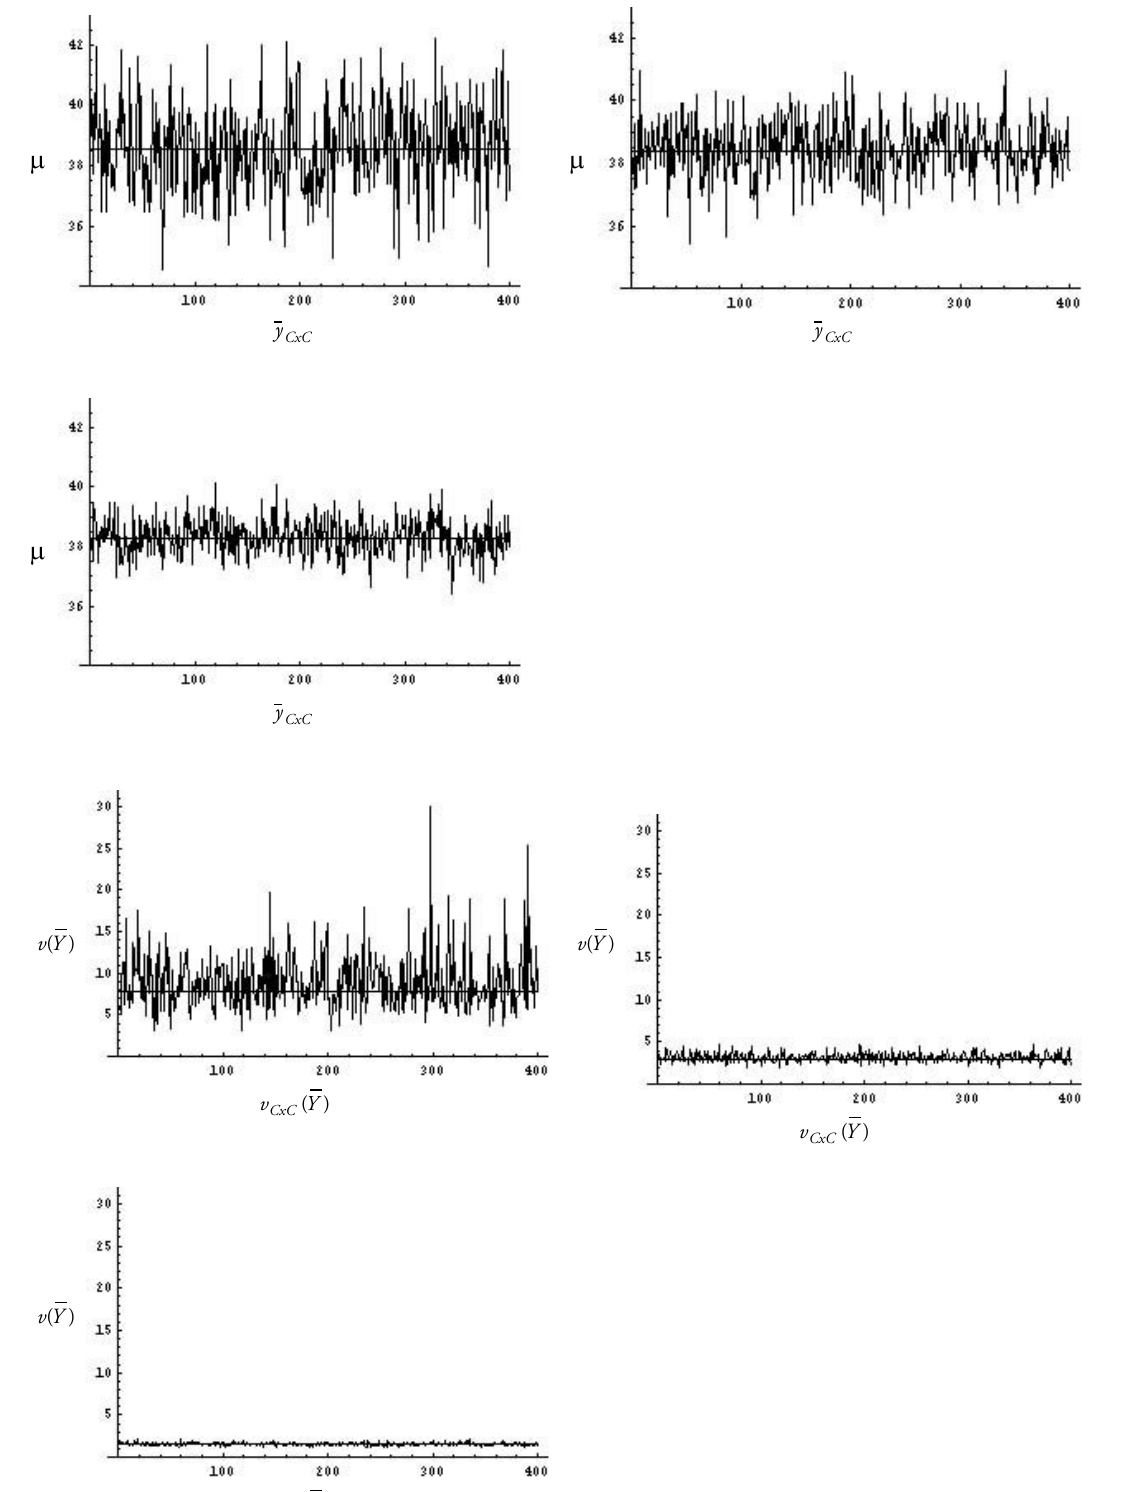
e v Y ( ) per valori crescenti a N ed n CxC CxC